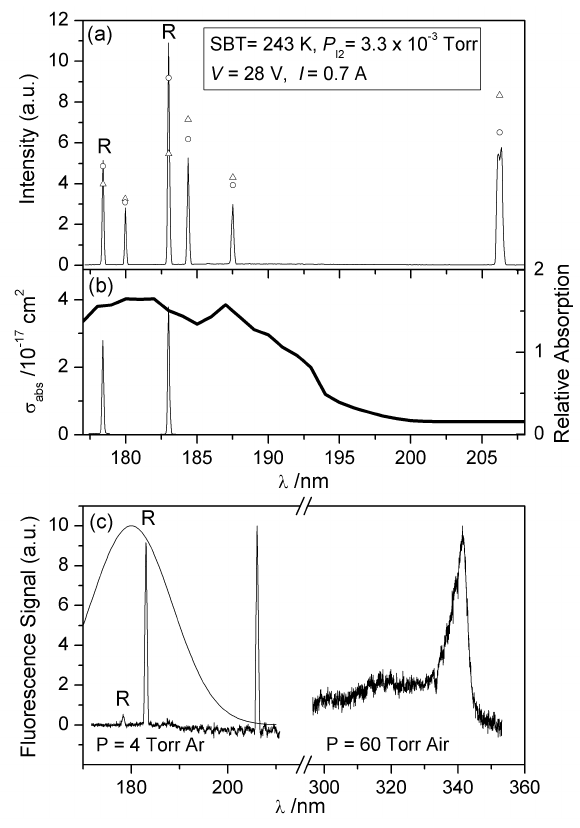
Fig. 1. ROFLEX excitation (a) , absorption (b) and fluorescence (c) stages. (a) shows a lamp emission spectrum for a side branch tem- perature (SBT) of 243K, recorded with a VUV grating spectrom- eter and a CCD ( R = resonance line). Line peaks at SBT = 293K ( 4 ) and 273K ( (cid:13) ) are also shown. (b) shows the I 2 UV absorp- tion cross sections (thick line) reported by Roxlo and Mandl (1980) and a relative absorption spectrum of atomic iodine in air (Spietz et al., 2001). (c) shows atomic (resonance) and molecular (off- resonance) dispersed fluorescence (see text for details). The trans- mittance curve of the VUV filter is shown as a solid thin line. The absence of the 206.163nm line in the atomic absorption spectrum (b) is due to efficient quenching of I( 2 P 1 / 2 ) by oxygen (Young and Houston,